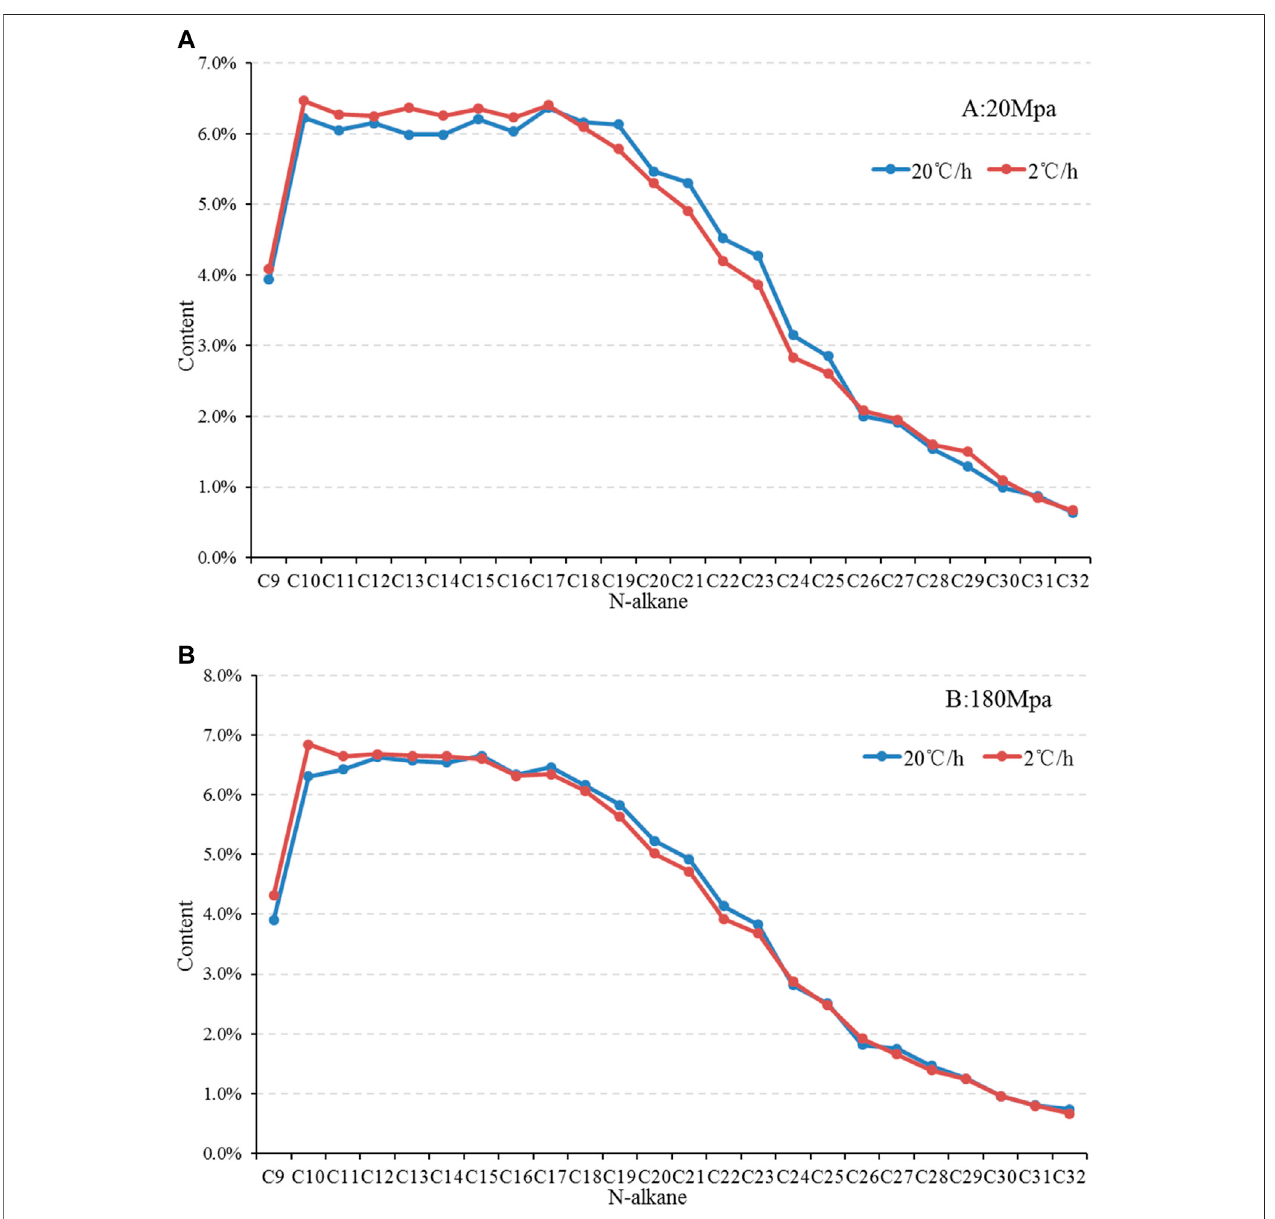
FIGURE 8 | Composition comparison of liquid hydrocarbon products of sample 2,911 under different heating rates [ (A) 20 Mpa, (B) 180 Mpa].